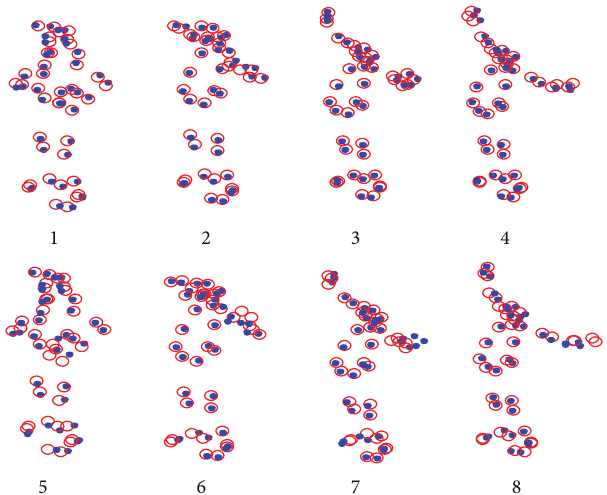
Figure 7: 3D reconstruction results on the “Stretch” sequence with two methods, respectively. The red dots denote the ground truth coordinates and the blue circles denote the estimation coordinates. The top row is the reconstruction result with sparse approximation and the bottom row is with the DCT trajectory basis method. Both of the results of these two methods are shown with the 65 185 frames through different visualizations (better viewed in th